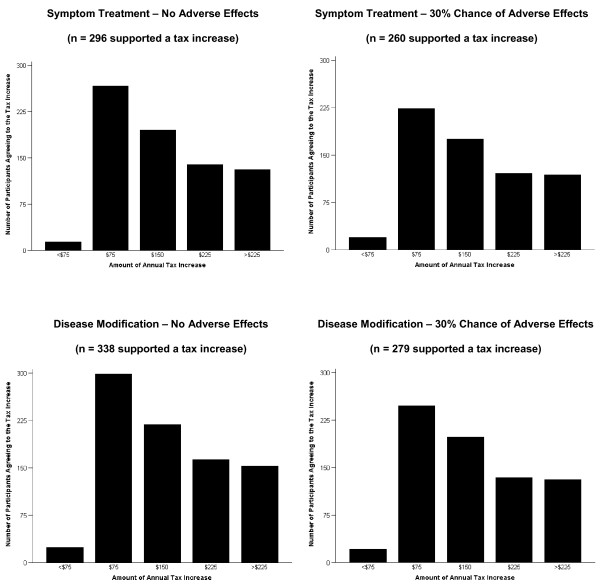
Number of participants agreeing to specific annual income tax increases to fund a program of unrestricted access to an Alzheimer's disease medication. Participants may have agreed to more than one of the values in each scenario. The number of participants in each scenario who agreed to values other than $75 was statistically significantly different (P < 0.05 [McNemar]) from the number who agreed to $75.